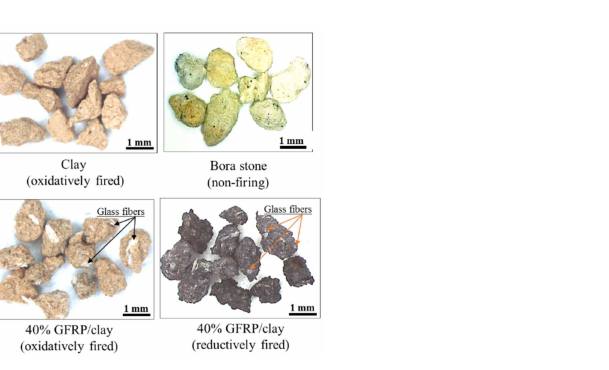
Figure 2. Microscope images of the granular GFRP/clay ceramic specimens.